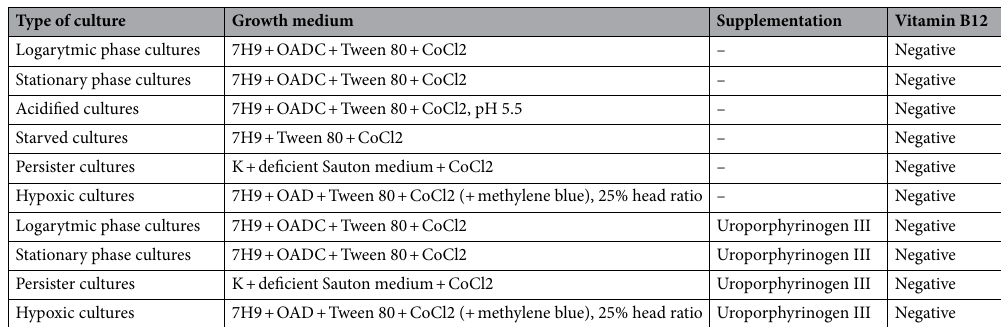
Table 3. Types of cultures tested for cobalamin in cells of M. tuberculosis H37Rv, five clinical strains of M. tuberculosis, and ∆ cobIJ .